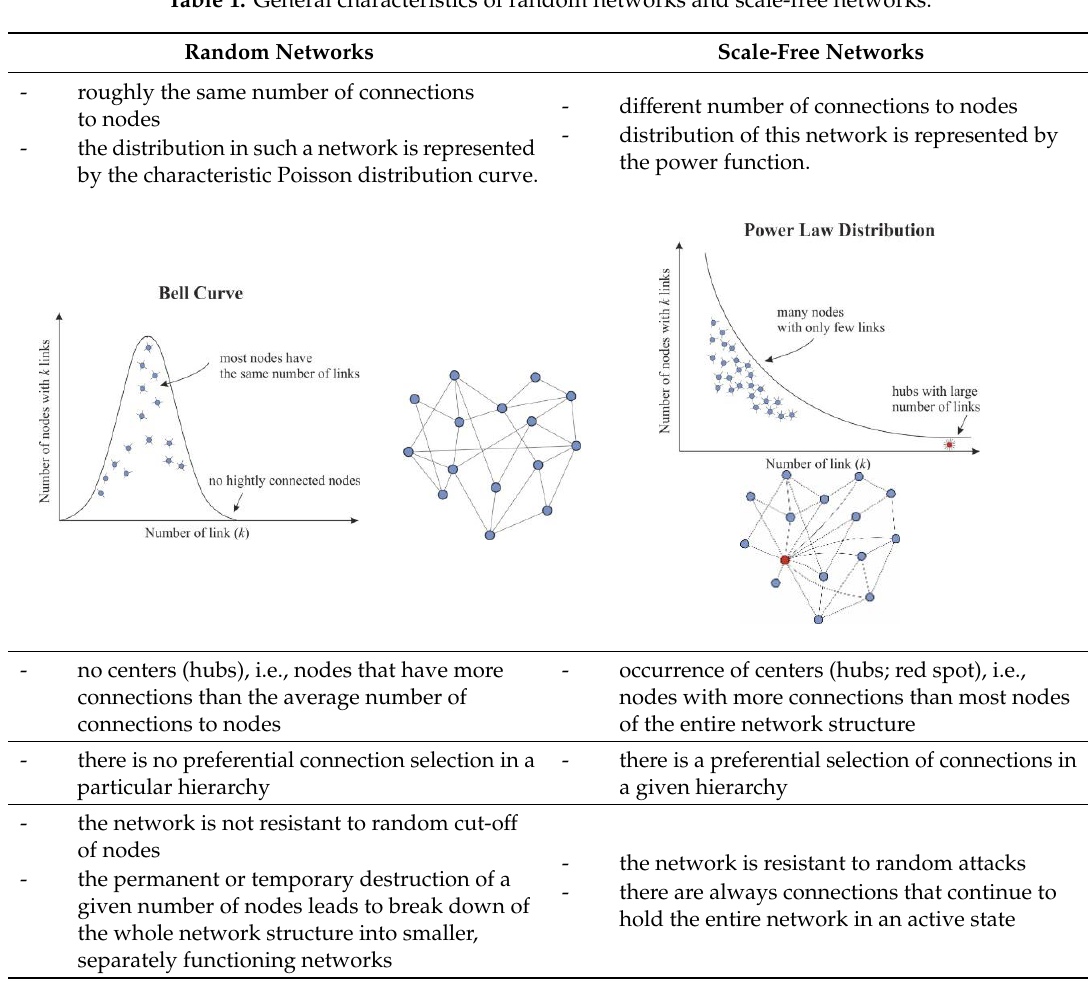
Table 1. General characteristics of random networks and scale-free networks.